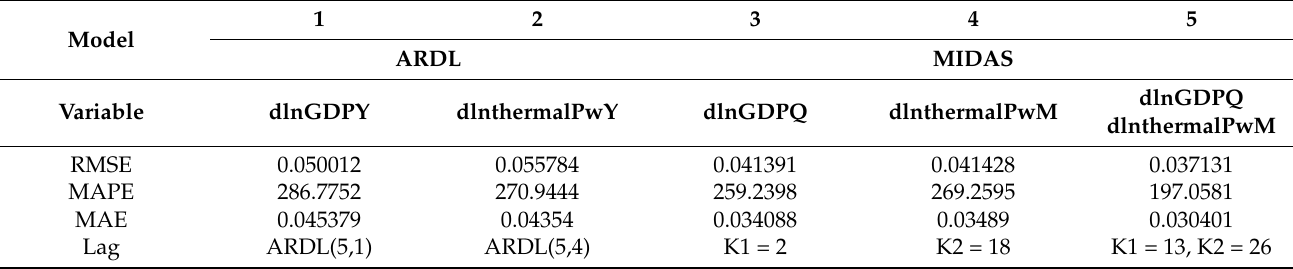
Table 4. Accuracy indices of different